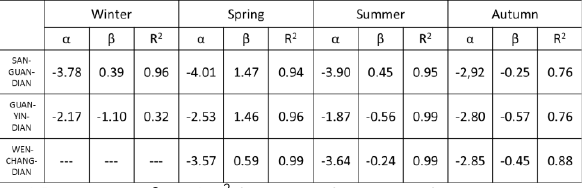
Table 2 、α、β and R 2 function of seasons of Beigang Chao- Tian